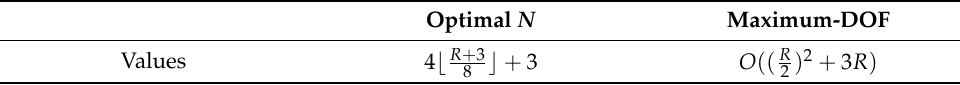
Table 1. Optimal parameters of array.